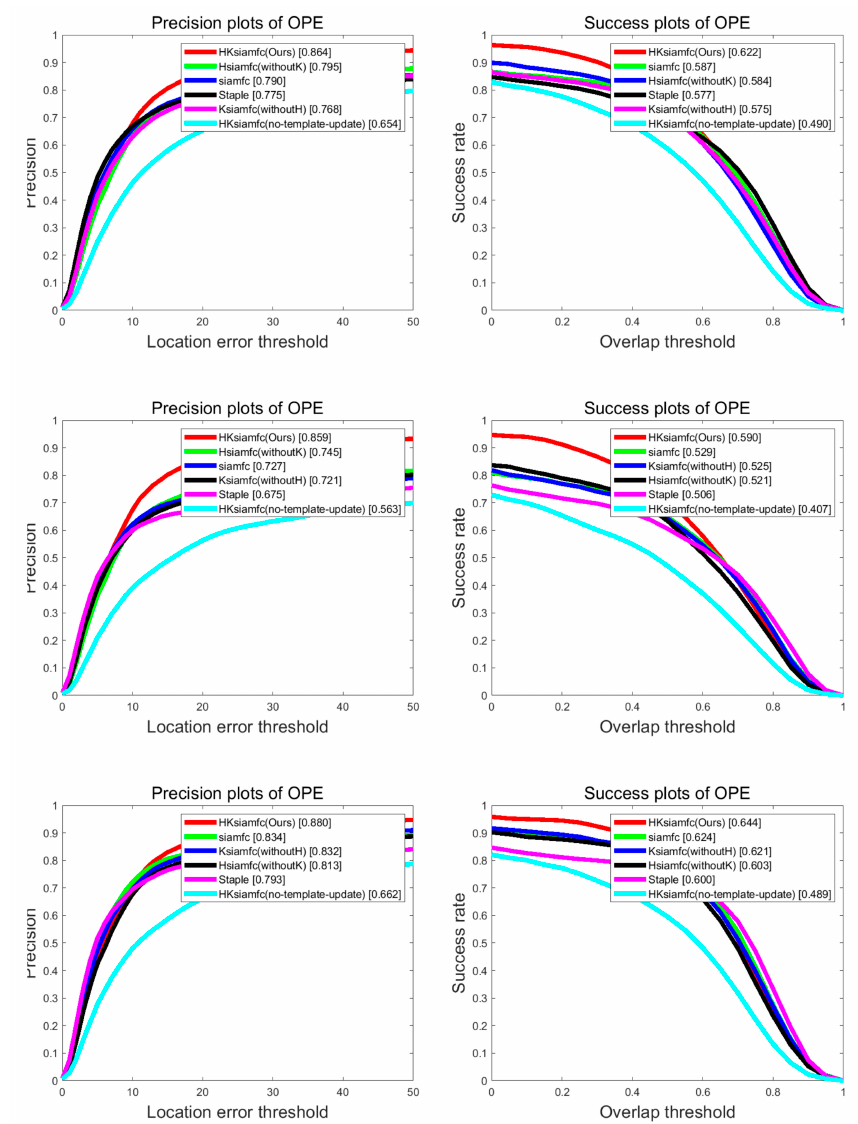
Figure 5. Comparison of HKSiamFC and five baseline trackers on Online Object Tracking Benchmark (OTB) dataset. Three plot pairs are results of ( top – bottom ) OTB100, OTB50, and OTB2013. This picture is best viewed on high-resolution displays.